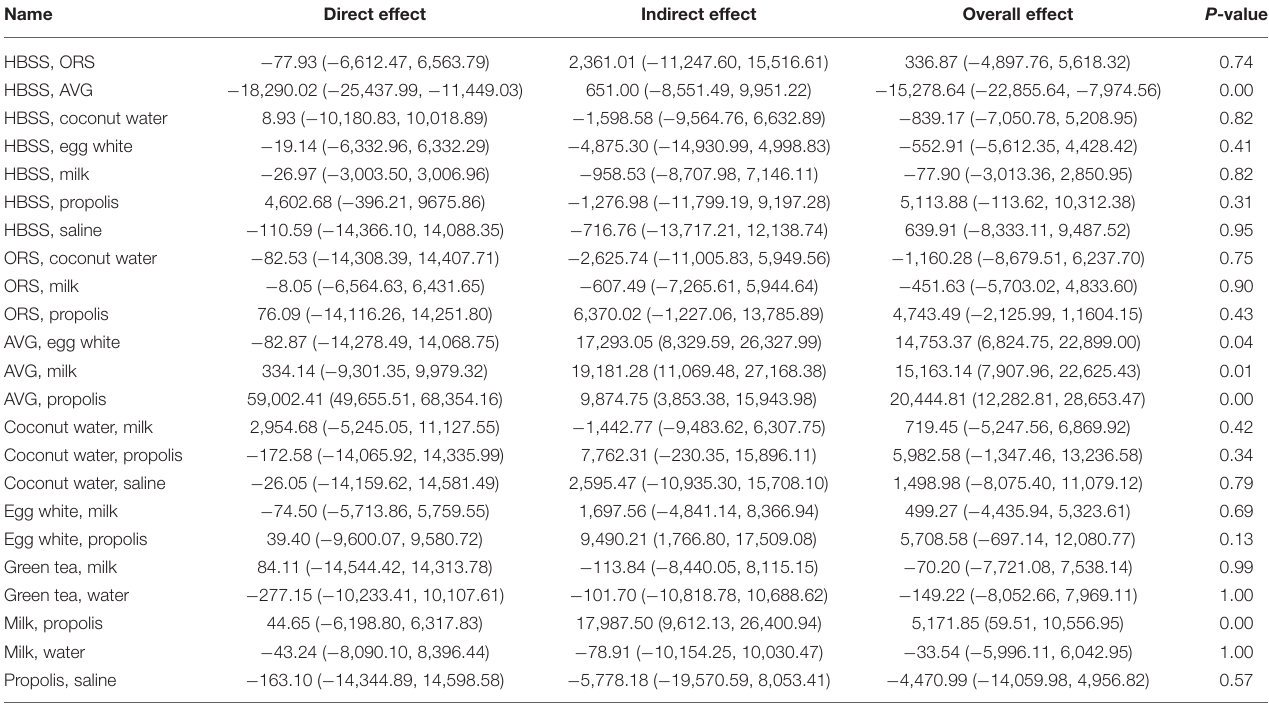
TABLE 2 | Inconsistency examination based on node split method.